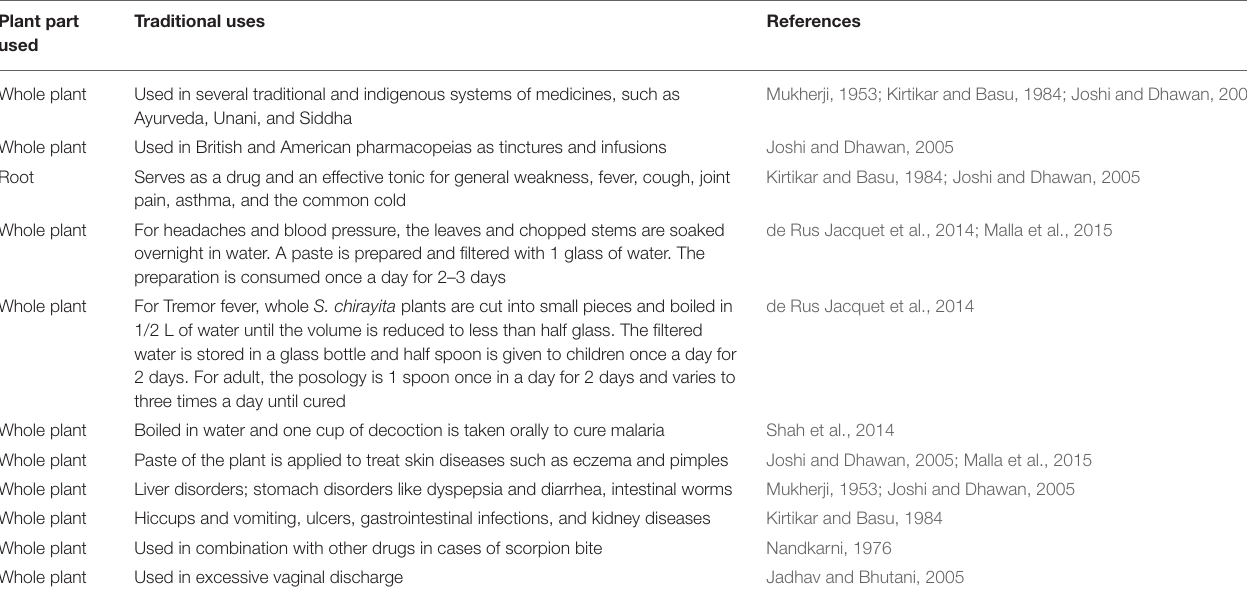
TABLE 1 | Ethnobotanical uses of Swertia chirayita in traditional medicine. Plant part